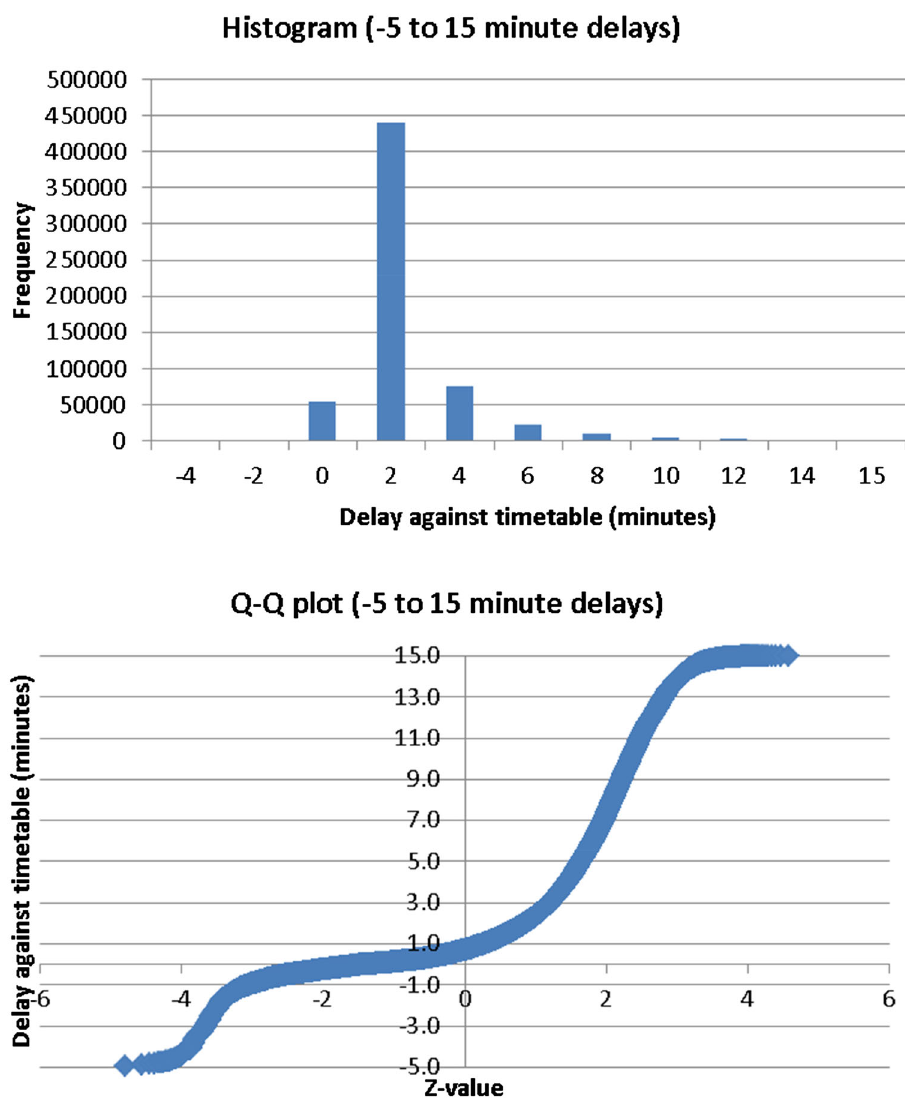
Fig. 2 Q–Q plot and